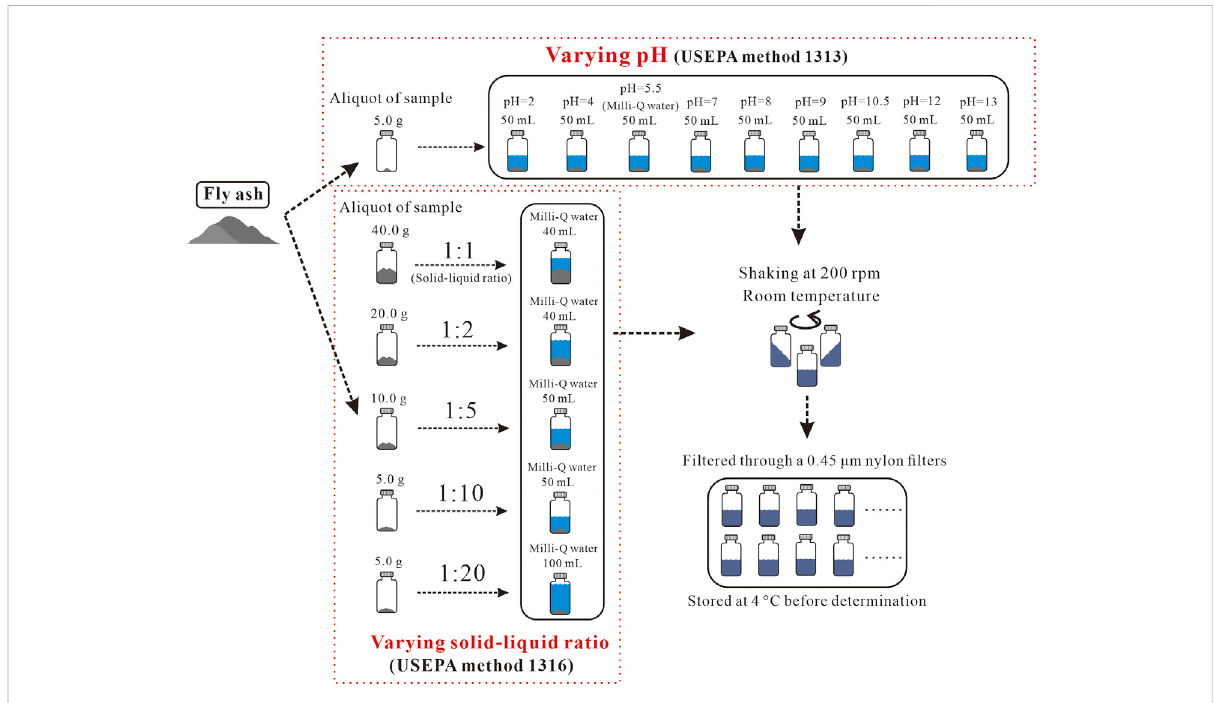
FIGURE 1 Leaching experiment process followed USEPA method 1313 and 1316.